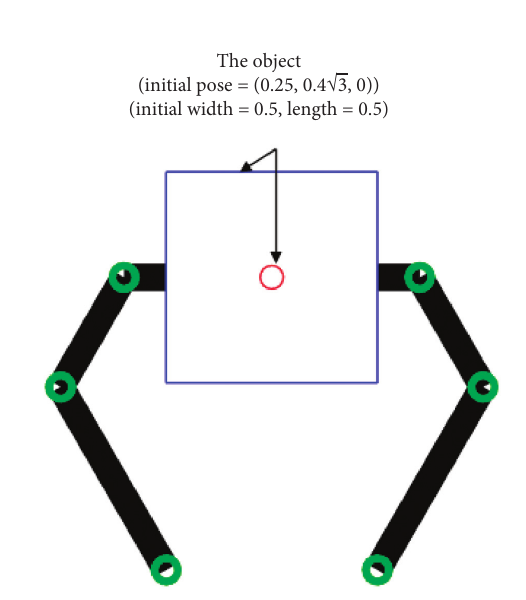
Figure 7: The initial state of the system in Cases 2–4.